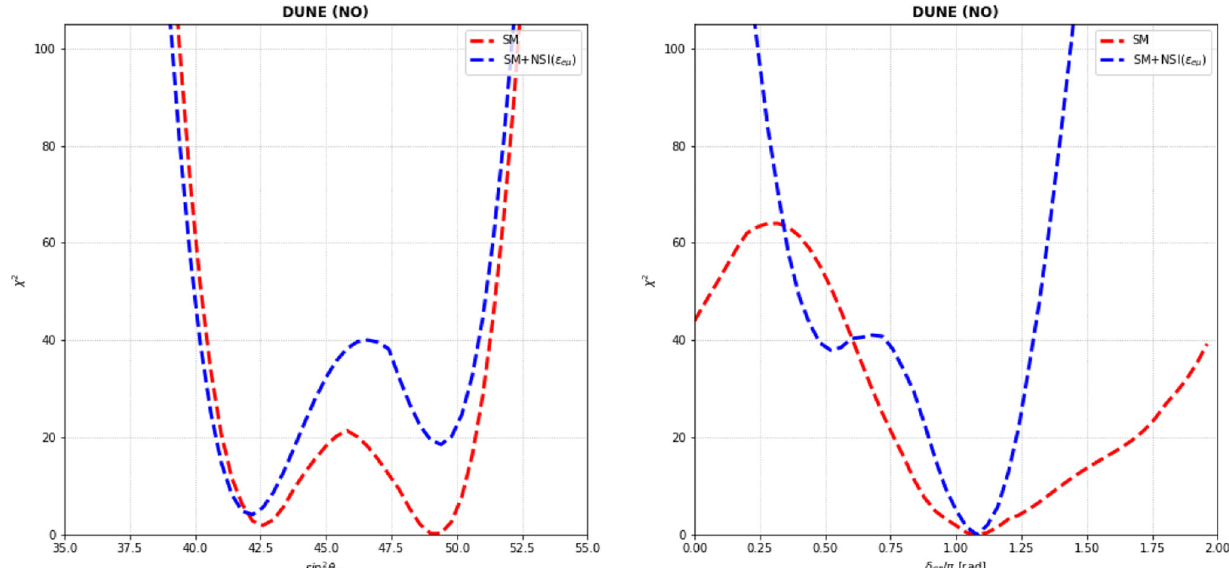
Fig. 4 One-dimensional projections of the standard parameters θ 23 (left) and δ CP (right) determined for DUNE in NO for SM (red dashed curves) and SM+NSI from e − μ scenario (blue dashed curves)